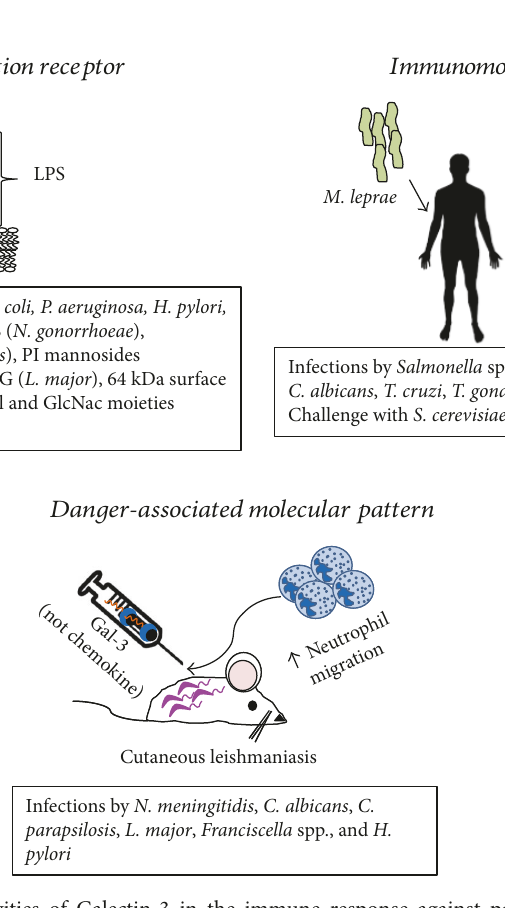
Figure 1: Di ff erent activities of Galectin-3 in the immune response against pathogens. Gal-3 = Galectin 3, LPS = lipopolysaccharide, LOS = lipooligosaccharides, PI mannosides = phosphatidylinositol mannosides, LPG = lipophosphoglycan, GlcNac = N-acetylglucosamine, E. coli = Escherichia coli , P. aeruginosa = Pseudomonas aeruginosa , H. pylori = Helicobacter pylori , N. gonorrhoeae = Neisseria gonorrhoeae , C. albicans = Candida albicans , L. major = Leishmania major , T. cruzi = Trypanosoma cruzi , S. pneumoniae = Streptococcus pneumoniae , M. leprae = Mycobacterium leprae , S. cerevisiae = Saccharomyces cerevisiae , N. meningitidis = Neisseria meningitidis , C. parapsilosis = Candida parapsilosis , T. gondii = Toxoplasma gondii